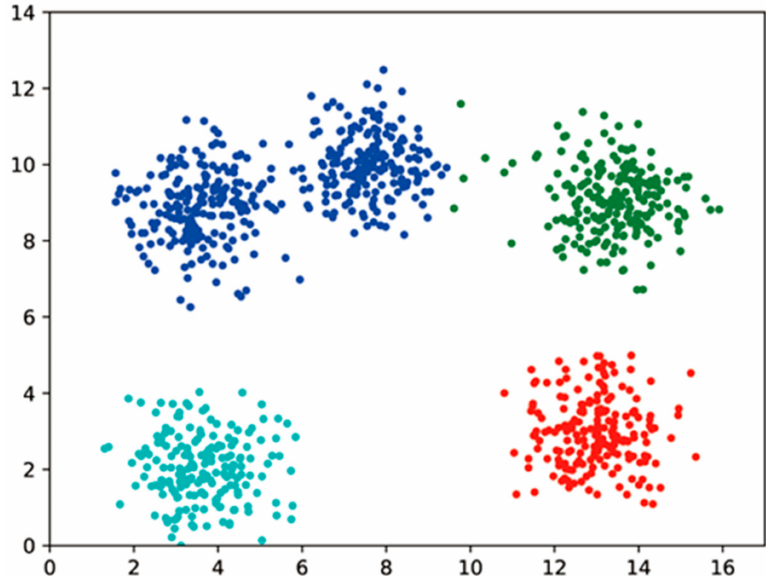
Figure 7. A plaintext clustering results.